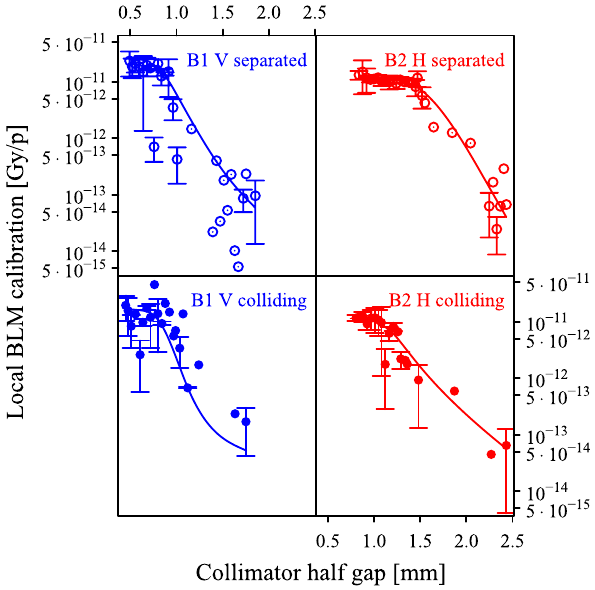
FIG. 5. Collimator jaw positions (right axis) and beam losses at different BLMs immediately downstream of the collimator used for scraping (left axis) as a function of time, for a portion of the collimator scan.